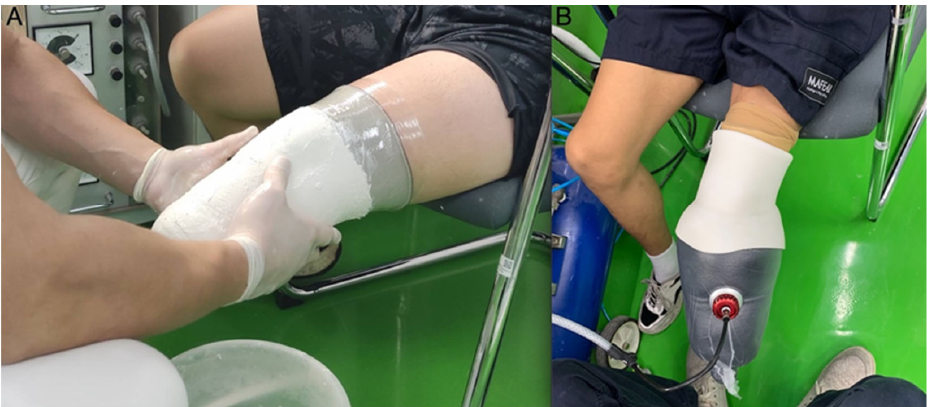
Figure 1. Image of (POP) plaster of paris and (PS) polystyrene bead casting methods. Note: ( A ) POP: plaster of paris casting; ( B ) PS: polystyrene bead casting.